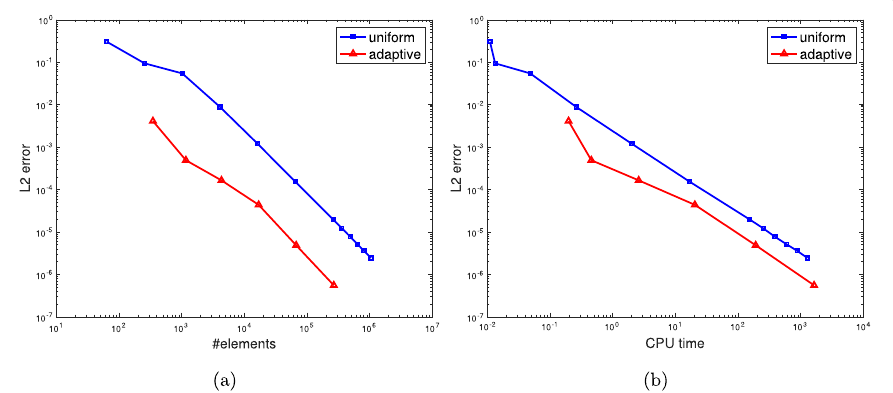
Fig. 5 L 2 errors of density as functions of the final number of elements and CPU time(s) on uniform and adaptive meshes for the evolution of an isentropic vortex. ( a ) L 2 error versus #elements; ( b ) L 2 error versus CPU